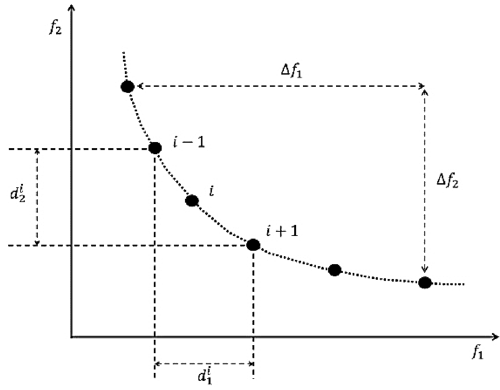
Figure 2. Calculating crowding-distance for point i